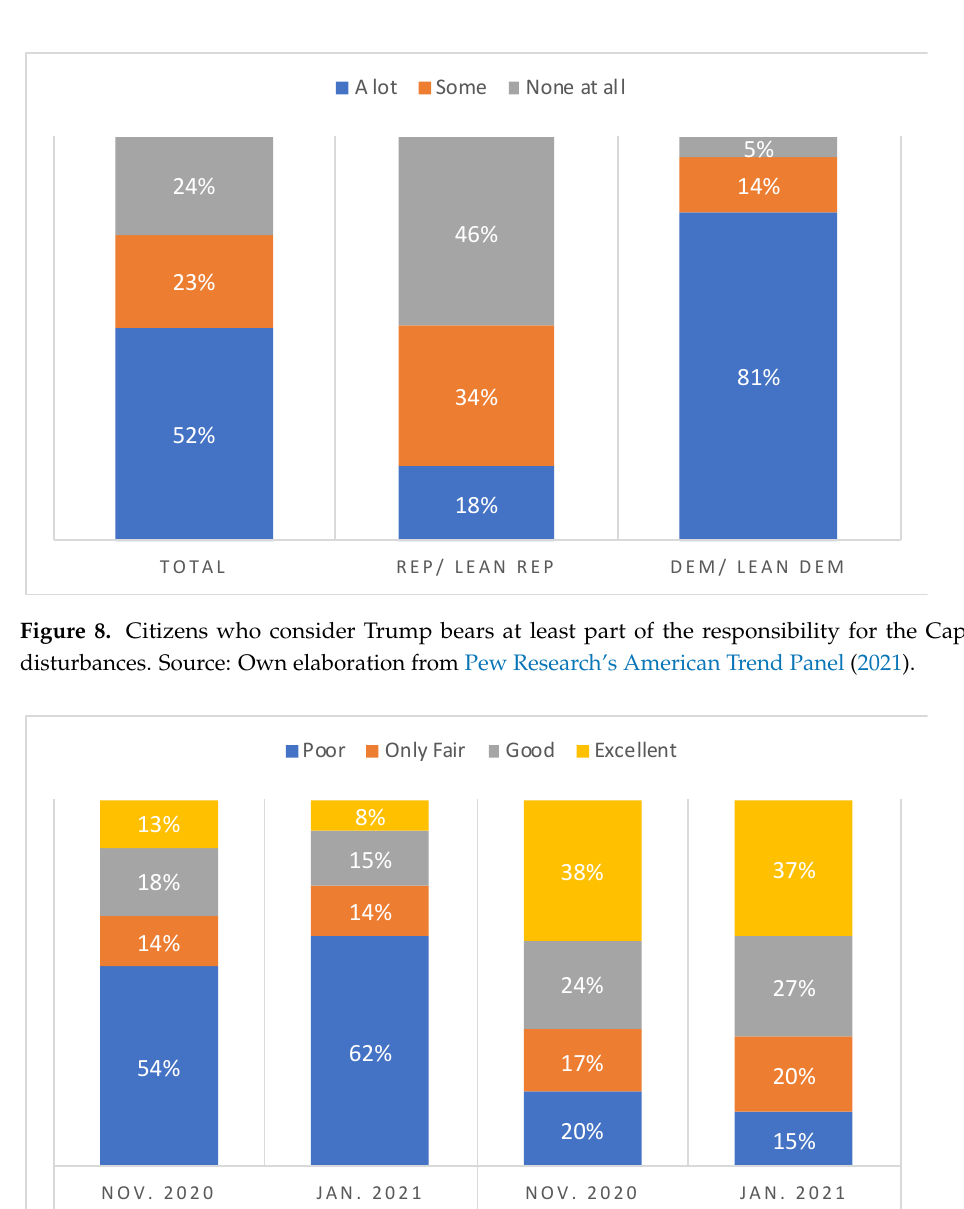
Figure 9. Evolution of the evaluation of Trump’s and Biden’s behavior after the presidential election. Source: Own elaboration from Pew Research’s American Trend Panel (2021).